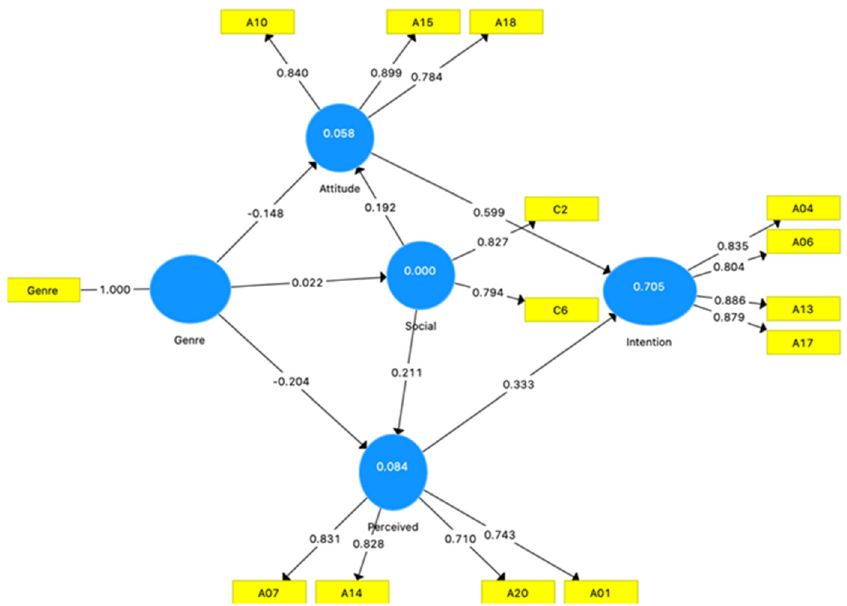
Figure 2. PLS Model for model 1 (all).